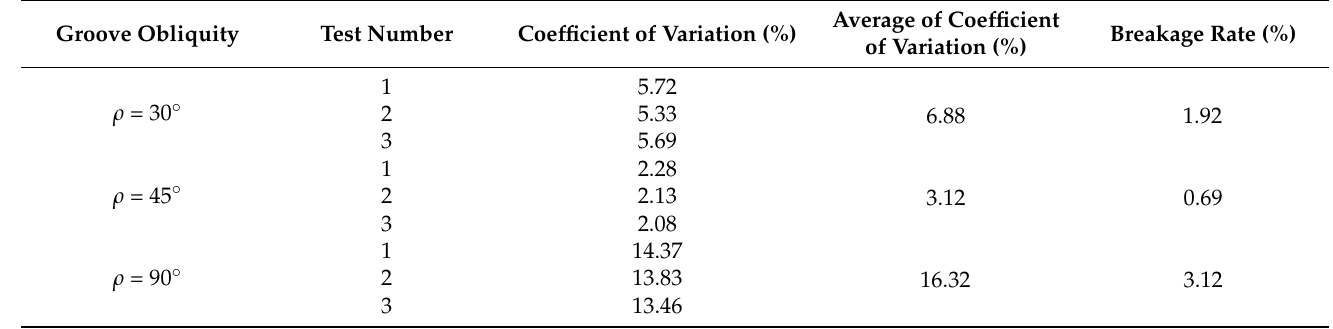
Table 4. Pulsating variation coefficient and breakage rate of seed flow discharge under different spiral groove inclination